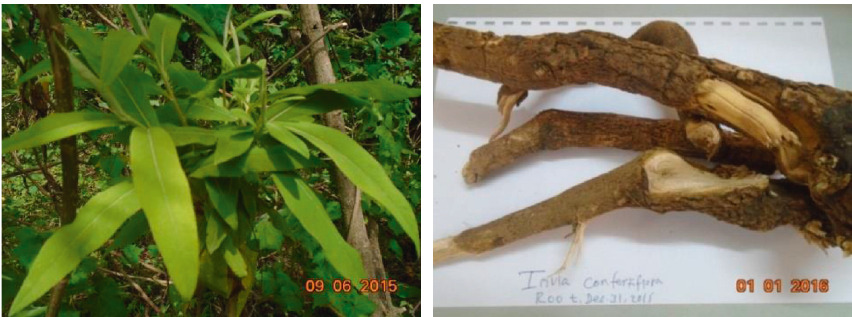
Figure 1: Inula confertiflora leaf (left) and root (right) parts (photo by